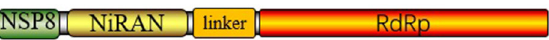
FIGURE 1 | Structure diagram of NSP9 of PRRSV. N-terminal is linked to NSP8 and contains a newly discovered nucleotide transferase domain (NiRAN) related to pancreatic virus RdRp, and C-terminal contains the RdRP